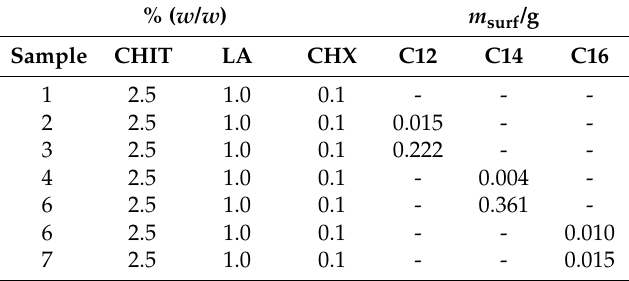
Table 5. Composition of prepared